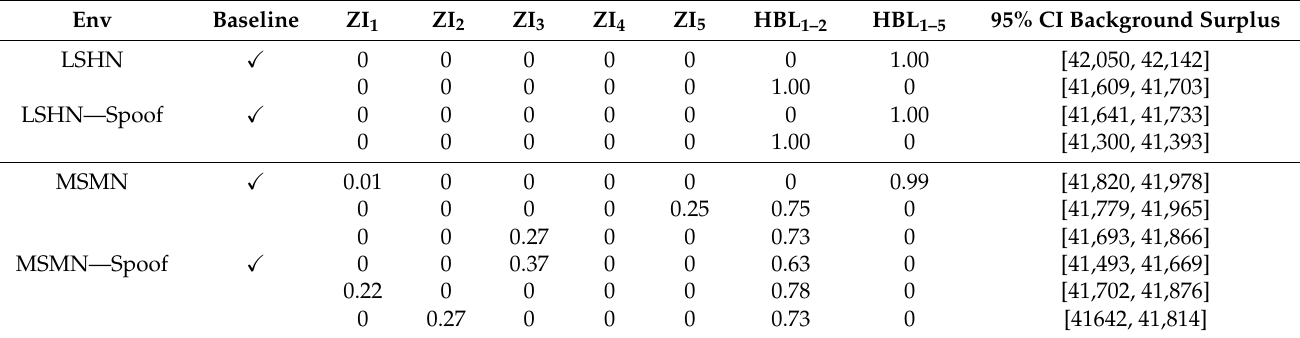
Table A17. Equilibria for games where the learning-based trading strategy set is restricted to standard HBL. Each row describes an equilibrium found for the game described by the Env column, detailing the adoption rate of each strategy considered and the corresponding background surplus. The equilibrium strategy profiles with checkmarks in the “Baseline” column indicates those used as baseline strategy profiles for controlled